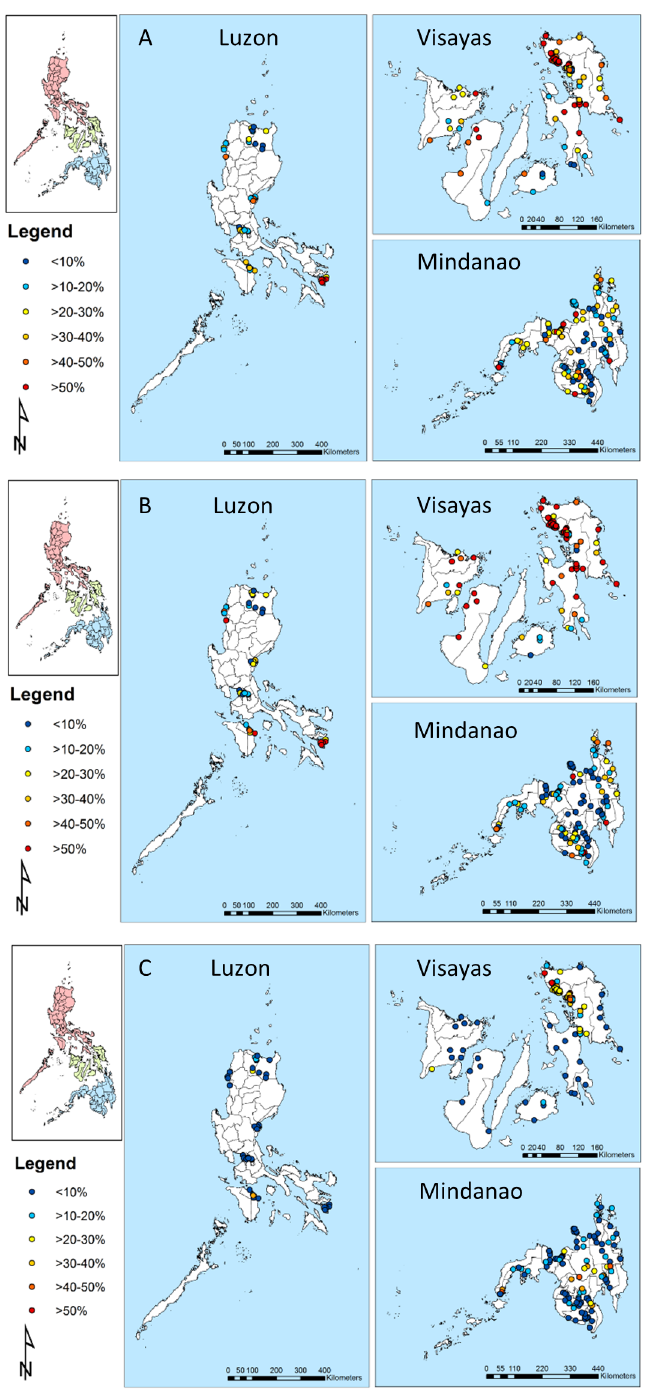
Fig 1. Geographical distribution of survey locations and observed prevalence for Ascaris lumbricoides (A), Trichuris trichiura (B) and hookworm (C). Note: Luzon – left, Visayas – top right and Mindanao – bottom